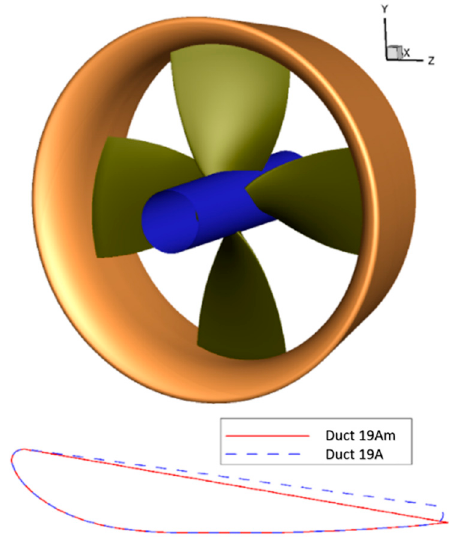
Figure 7. KA4-70 ducted propeller geometry (upper) and the duct cross section (lower). The modified Duct 19Am, with sharp trailing edge, is utilized in the calculations and the experiment at MARIN [13]. FWA is applied to a square-tip ducted propeller to investigate the effects of the blade/duct wake